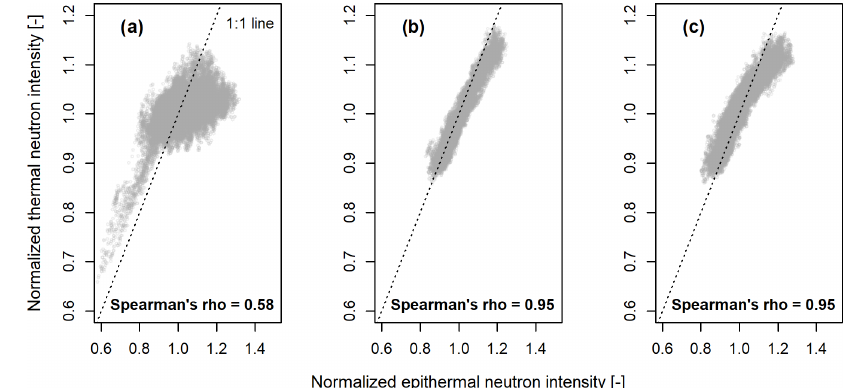
Figure 8. Relationship between observed normalized thermal and epithermal neutron intensity at the three CRNS sites, namely (a) site A, the main study site, (b) site B (soil moisture assumed to be uniform) and (c) site C (soil moisture assumed to be uniform). Normalized intensities were calculated by dividing by the respective time series mean.